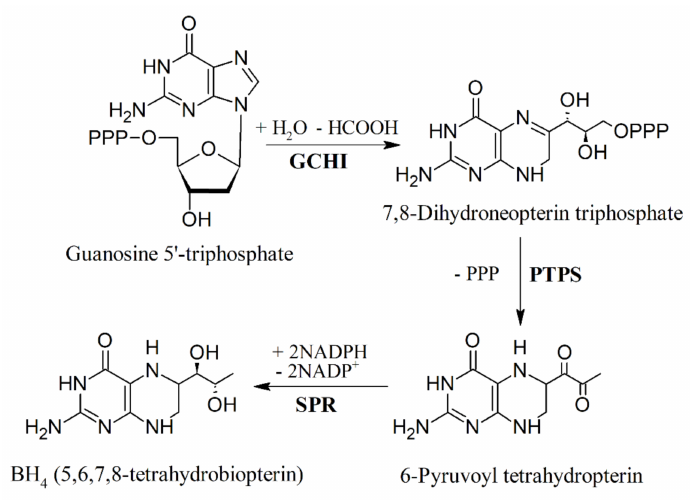
Figure 3. Biosynthesis of BH 4 in mammals. Modified from